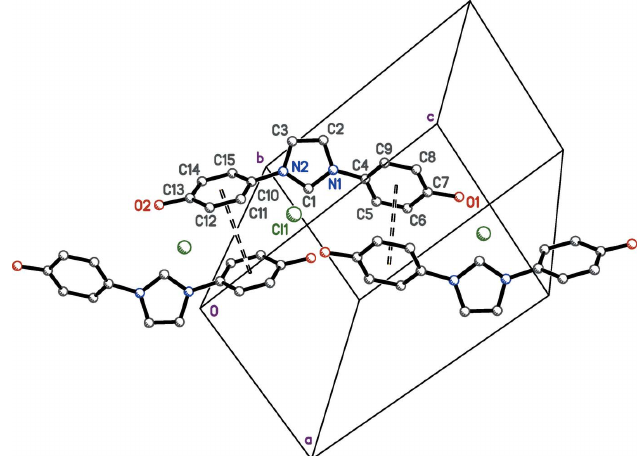
Figure 5 A plot highlighting the (cid:3) – (cid:3) stacking (open dashed lines) of benzene rings in crystals of IOH (cid:2) Cl. Unlabelled molecules are related to the labelled molecule by inversion [lower right: ( (cid:3) x + 1, (cid:3) y + 1, (cid:3) z + 1); lower left: ( (cid:3) x , (cid:3) y + 1, (cid:3) z